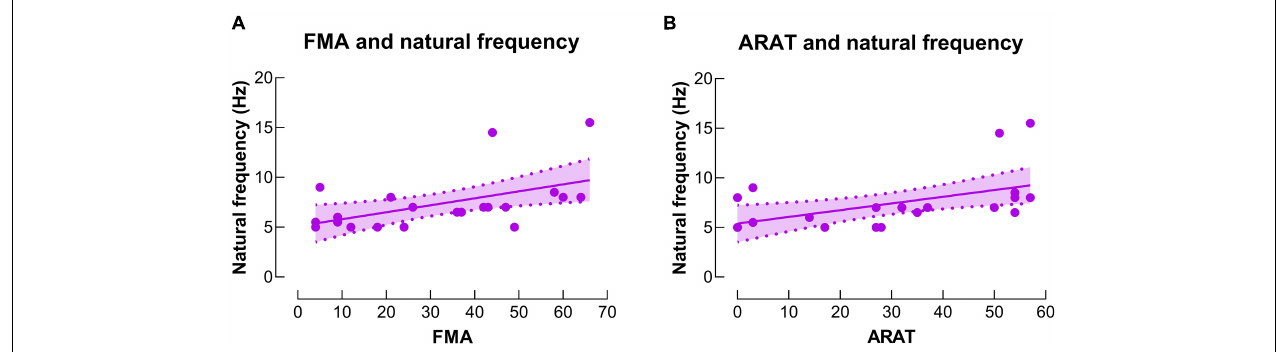
FIGURE 6 | Correlations between natural frequency and motor function. (A) There was a significant positive correlation between natural frequency in the IH and upper extremity Fugl-Meyer assessment (FMA) score. (B) There was a significant positive correlation between natural frequency in the IH and action research arm test (ARAT)